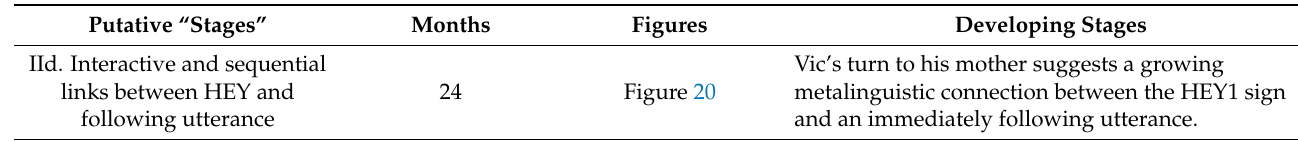
Vic’s contributions to conversational exchanges